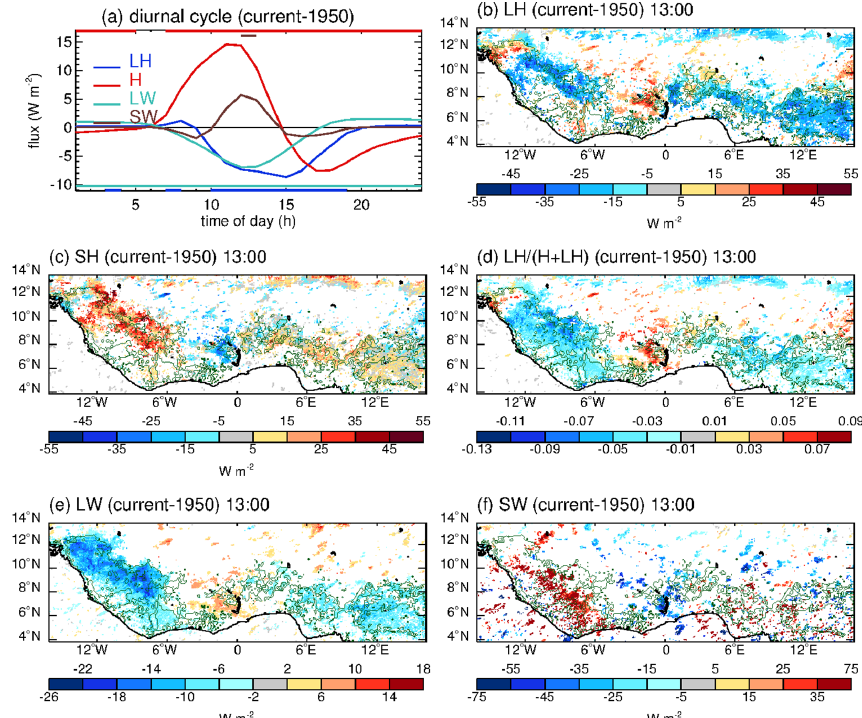
Figure 4. (a) Diurnal cycle of changes in turbulent and radiative heat fluxes averaged over all deforested pixels, with times when differences are significant indicated by coloured bars at the top and bottom. Differences in fluxes during the day (13:00UTC): (b) latent heat, (c) sensible heat, (d) evaporative fraction, (e) net down surface longwave, and (f) net down surface shortwave. Insignificant changes are shown in white (for SW this is the individual pixel significance, whereas for other variables FDR correction has been applied), whereas small but significant changes either side of zero are shown in grey. Green contours show where there has been